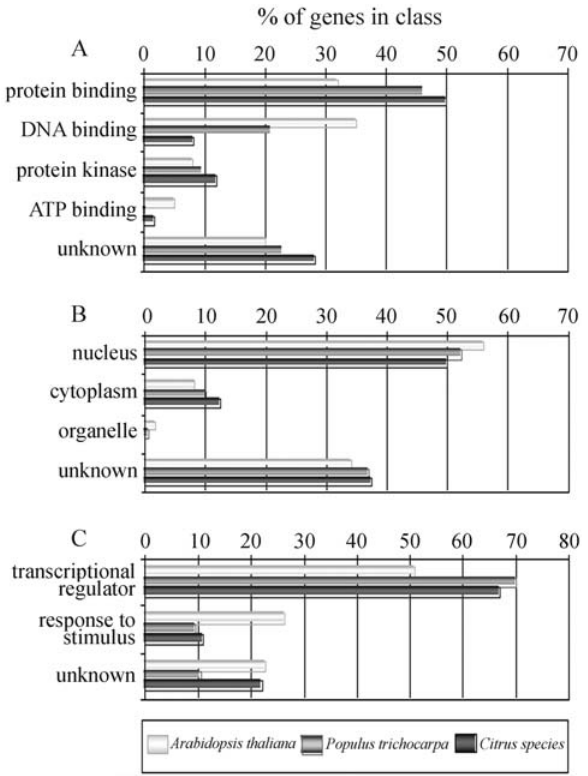
Figure 1 - Functional classification of citrus transcripts associated to the endogenous time-keeping mechanism using gene ontology. A. molecular function; B. cellular component; C. biological process. Assignments are based on the data available at the TIGR Arabidopsis thaliana Gene Index version